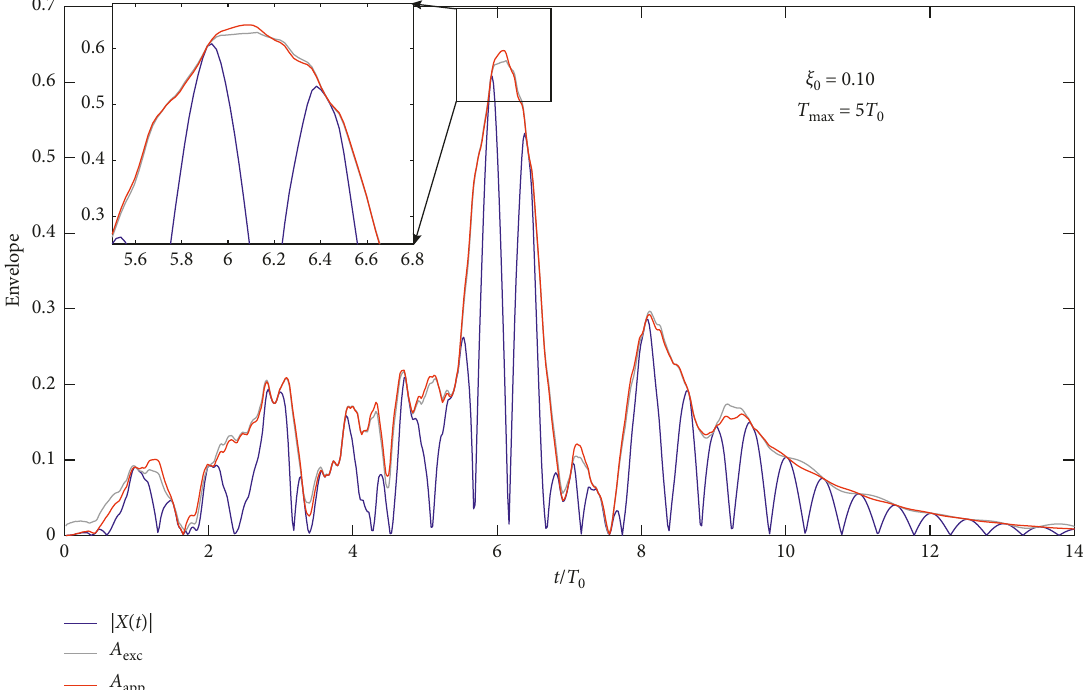
Figure 4: Structural displacement X